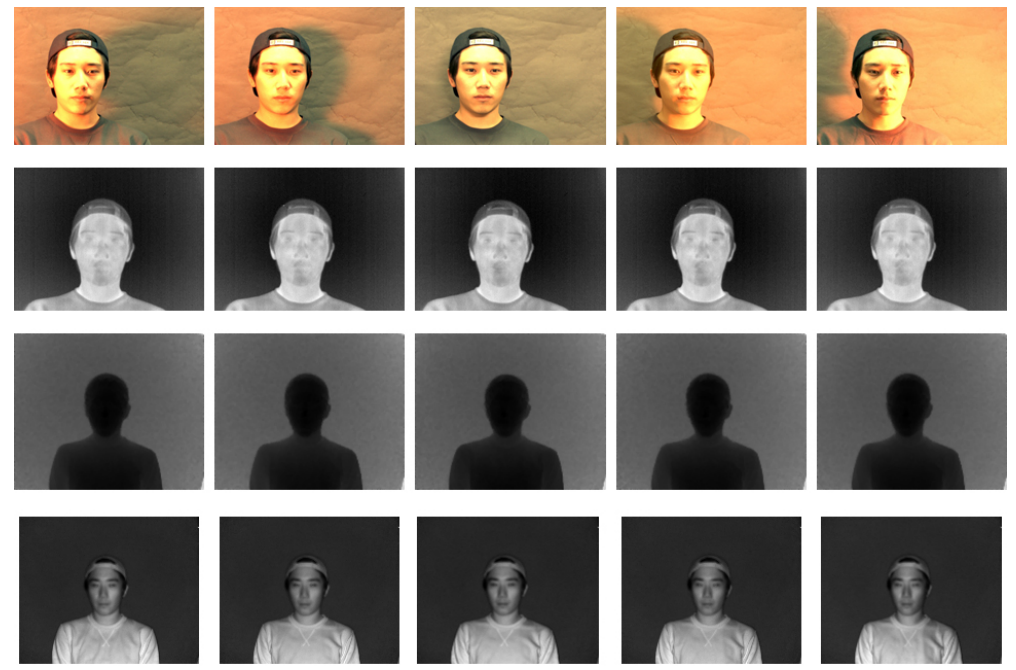
Figure 21. An example from the face database having five different light angles: 90 ◦ left, 45 ◦ left, front, 90 ◦ right and 45 ◦